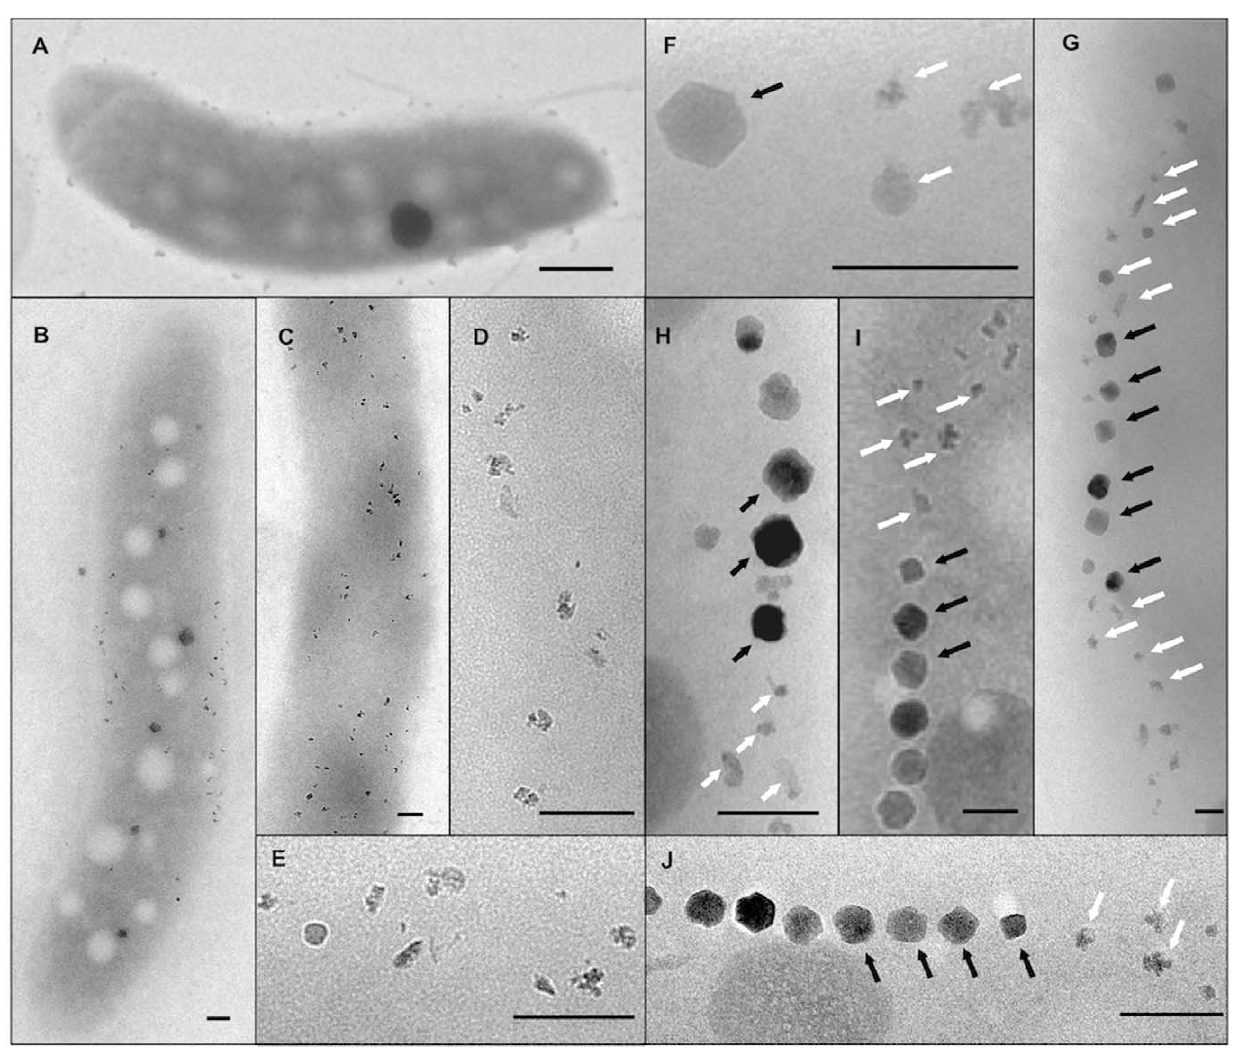
Figure 3. Representative TEM micrographs of magnetosome morphologies found in different cells of the D A8 deletion mutant. A) Cells without any electron-dense particles, B–E) irregularly shaped crystals lacking chain configuration, F–J) chains of regular crystals (black arrows), flanked by small particles with irregular morphologies (white arrows). Scale bar: 100 nm.